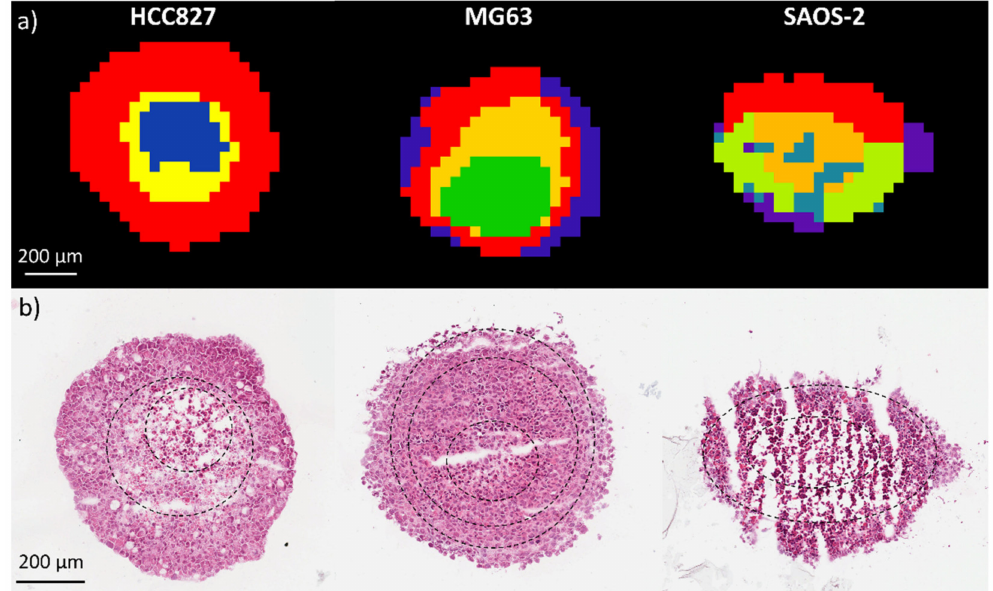
Figure 1. Spatial segmentation of a HCC827, MG63 and SAOS-2 aggregoid from metabolite data by DESI-MSI. ( a ) Spatial segmentation identified heterogeneous clustering phenotypes between aggregoid models. Segmentation of each sample was performed independently and therefore the coloured clusters do not correspond between samples. ( b ) H&E stain of same aggregoid sections from each model. Black dotted line highlights the approximate phenotypical regions identified by segmentation clustering analysis. Scale bar 200 µ m.